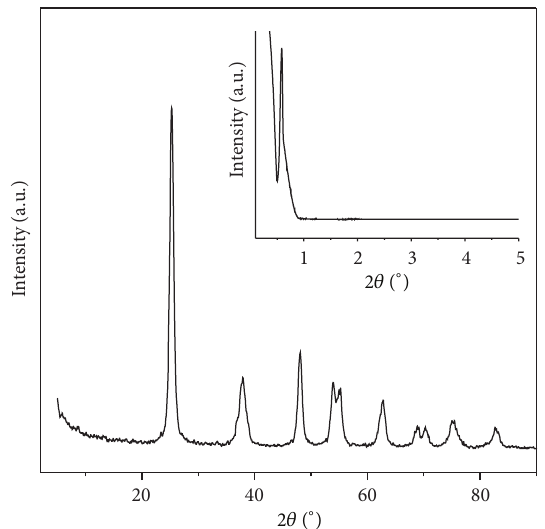
Figure 2: XRD wide and small angle patterns of MTiO 2 /RRP.